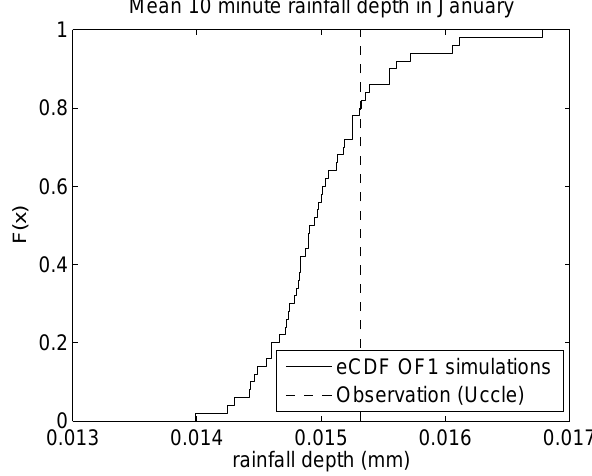
Fig. 8: Empirical Cumulative distribution function of the mean 10 minute rainfall depth in January as simulated with OF1 vs. observed value